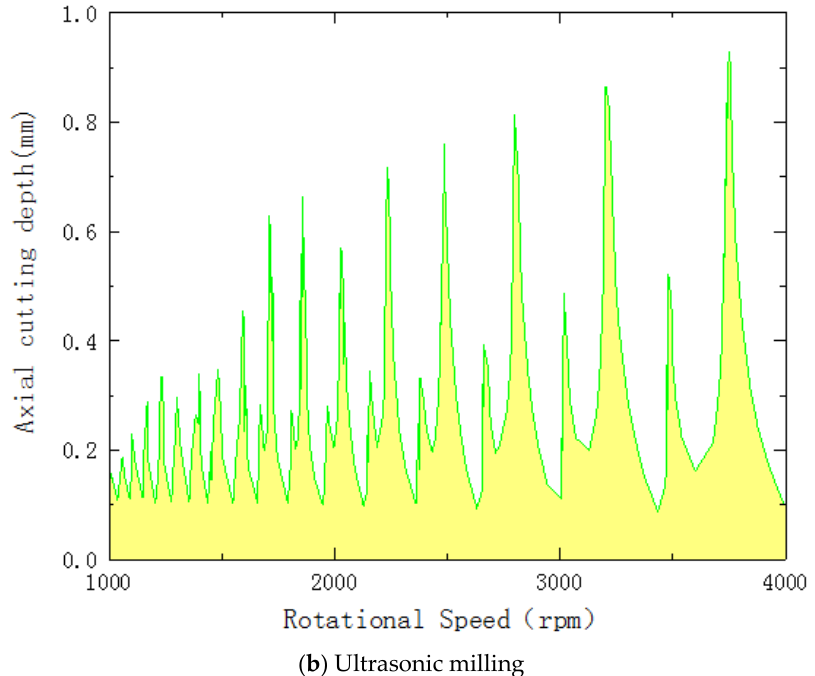
Figure 16. Directivity pattern under different processing methods.